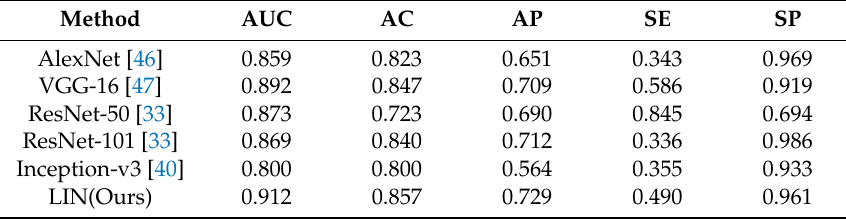
Table 10. Lesion classification performances of different